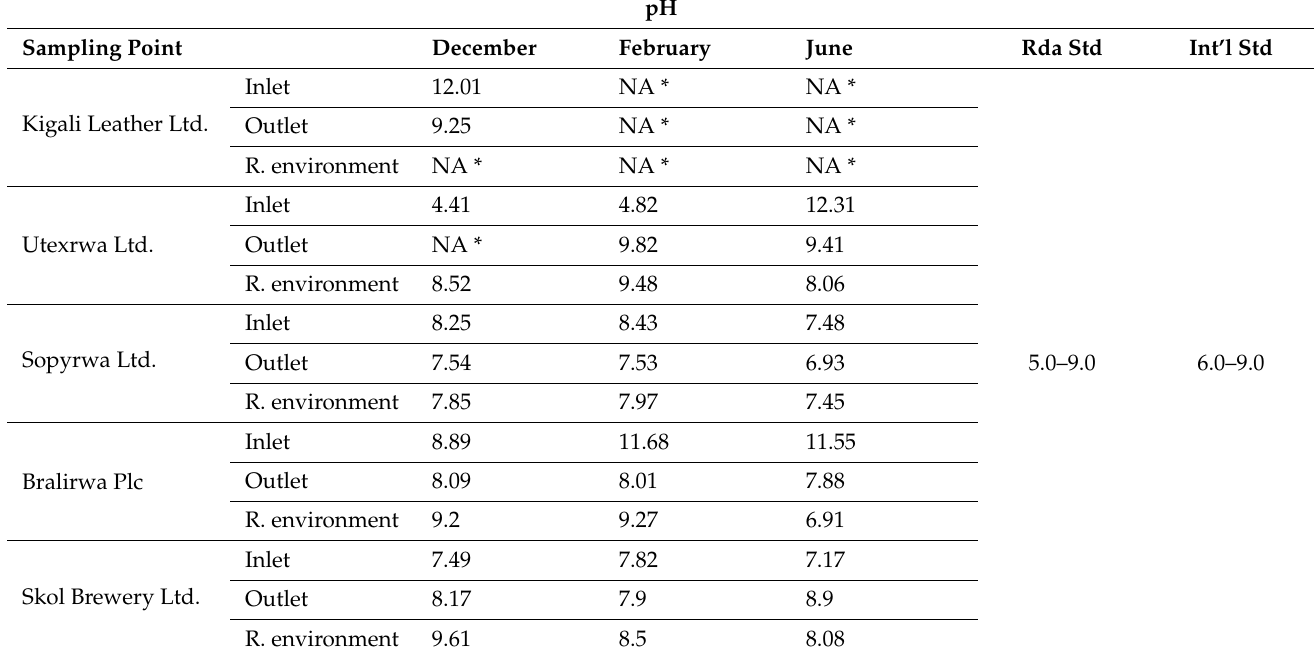
Table 2. pH results for the five selected